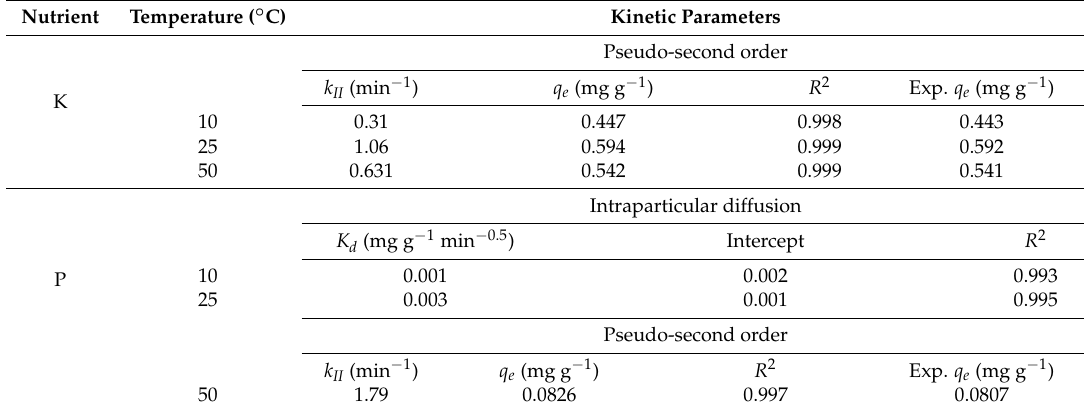
Table 3. Kinetic data for MgFe 200 /K 2 HPO 4 material Table